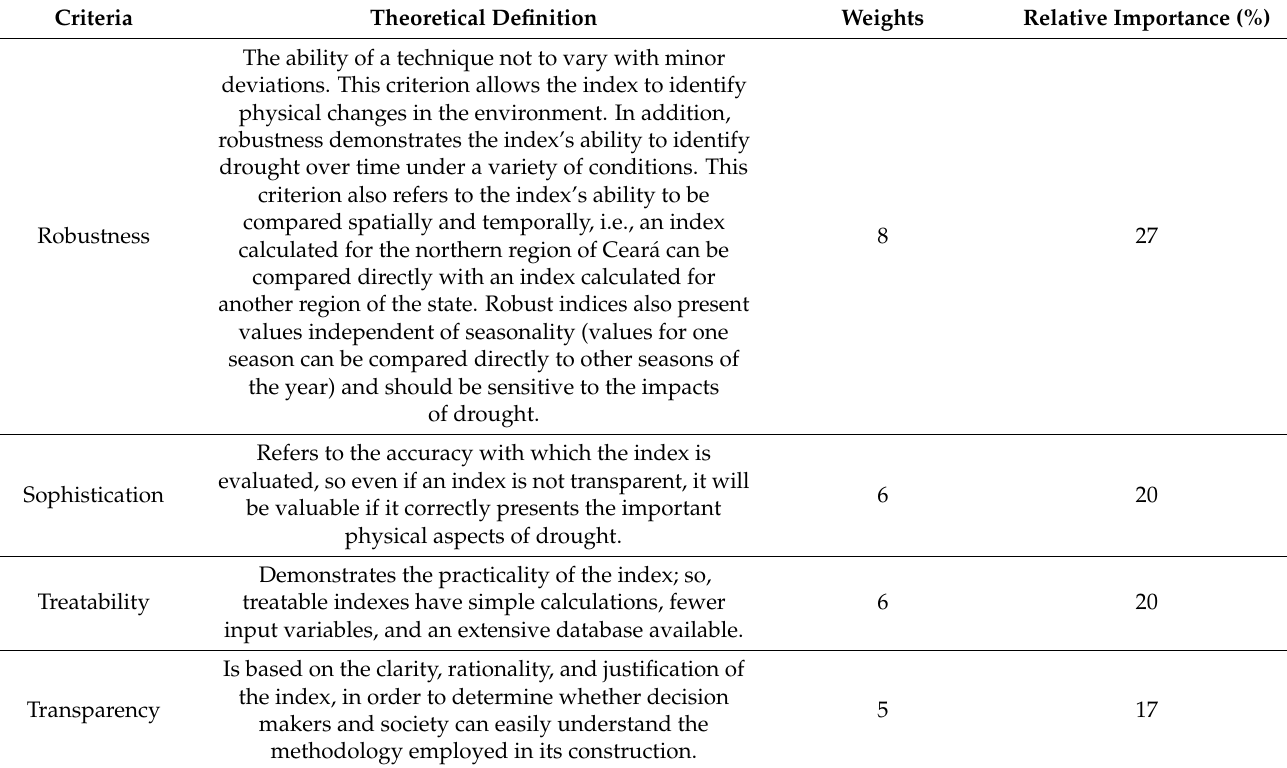
Table 9. Decision